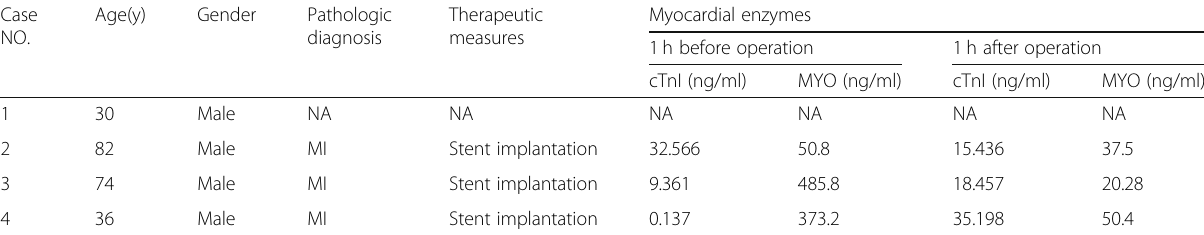
Table 3 Characteristics of the healthy control and 3 patients with MI Case